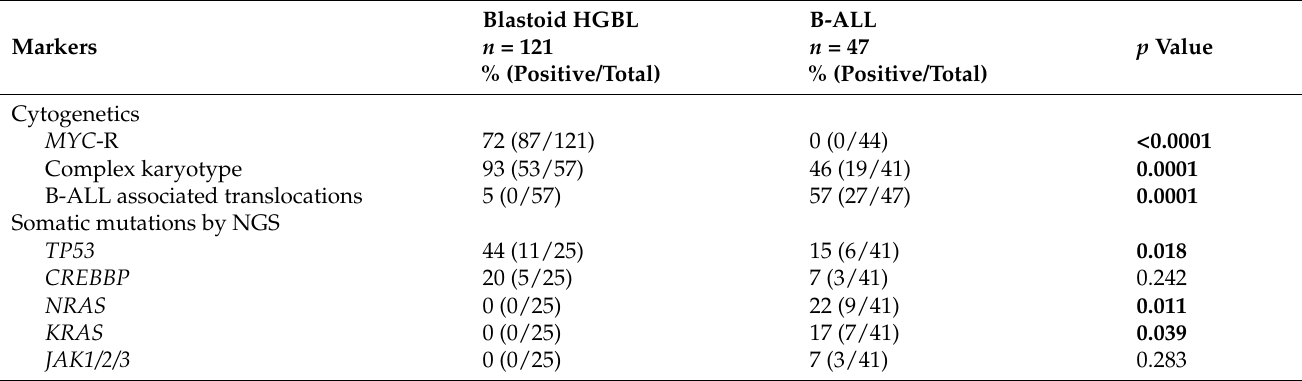
Table 2. Cytogenetic and molecular comparison between blastoid HGBL versus